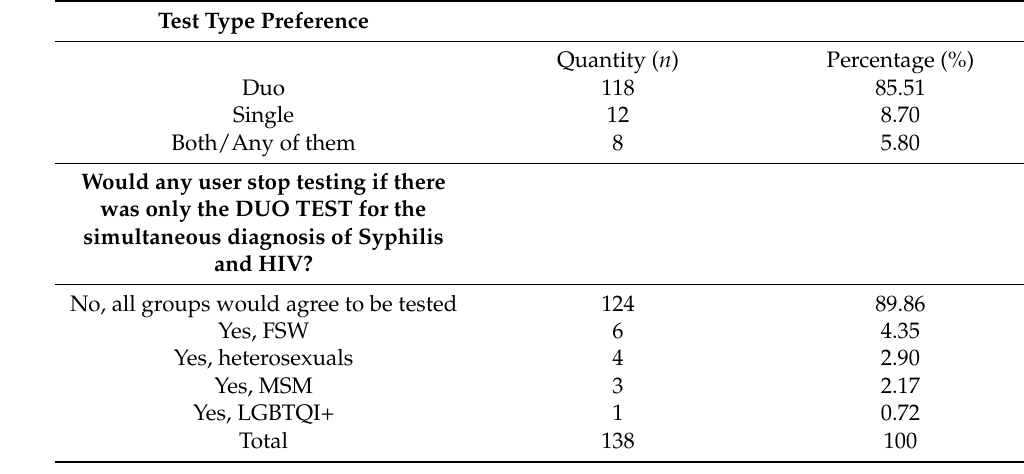
Table 4. Acceptability of the HIV-syphilis rapid diagnostic test among healthcare